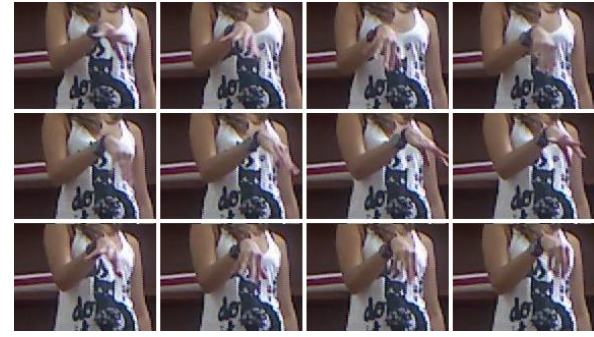
Figure 8. Sample00816, frames 1368-1408